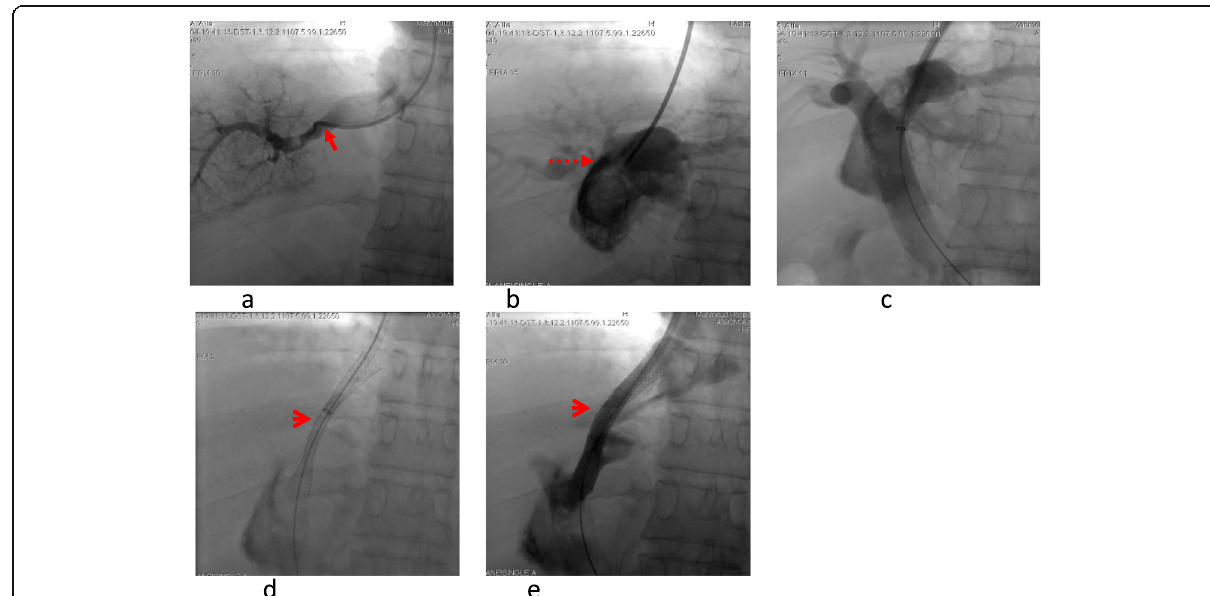
Fig. 3 Another TIPS case in the TIPS-LPV group. Middle hepatic (arrow) venography through a diagnostic catheter ( a ). The sheath catheter containing the needle was advanced inside the genu left portal (interrupted arrow) ( b ) with limited portography ( a ). Main portal venography was done with dilated portal vein ( c ). The delivered Wallstent (arrowhead) was inserted ( d ) with good flow shunting from left portal to cava ( e )